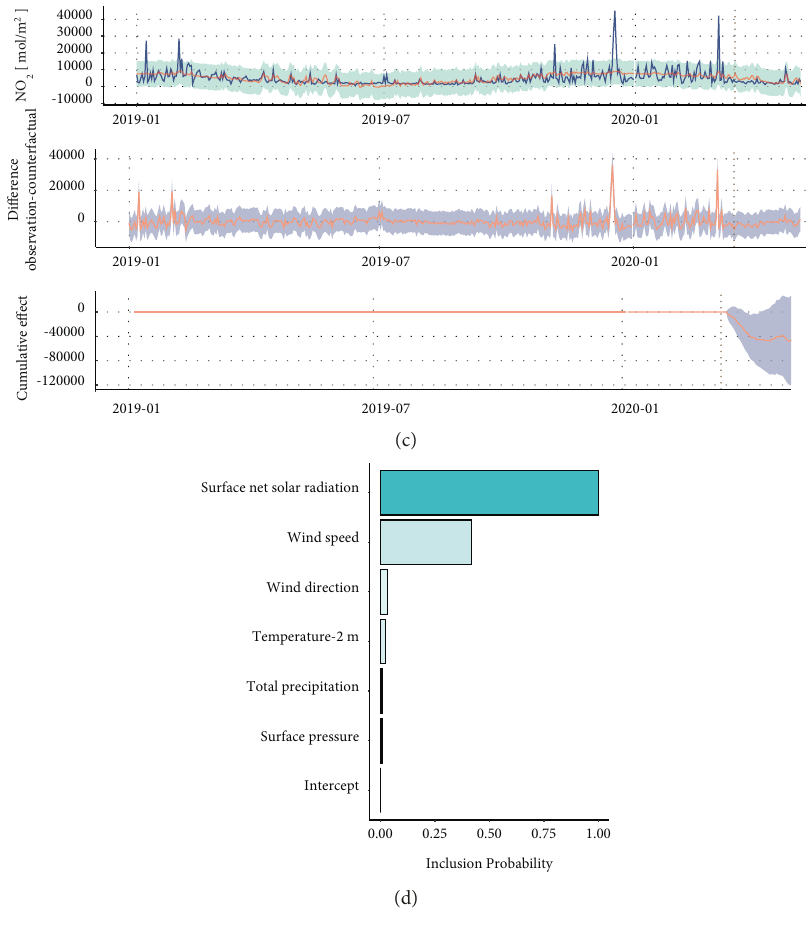
Figure 3: Causal analysis for the time course of the 16 observables. (a) Partial correlation network: each node corresponds to a variable, and the color encodes the type of variable meteorology, energy, mobility, and partial correlation value. (b) Granger causality network: the arrows are oriented in the causal direction; the variables which have a causal impact on NO are highlighted with solid edges. (c) Bayesian state- 2 space model: the top panel shows the data and a counterfactual prediction for the lockdown period. The middle plot shows the difference between observed data and counterfactual predictions. The bottom plot is the cumulative effect of the lockdown. (d) Probability of inclusion for the regressors: light-blue bars represent negative coefficients, while red bars represent positive